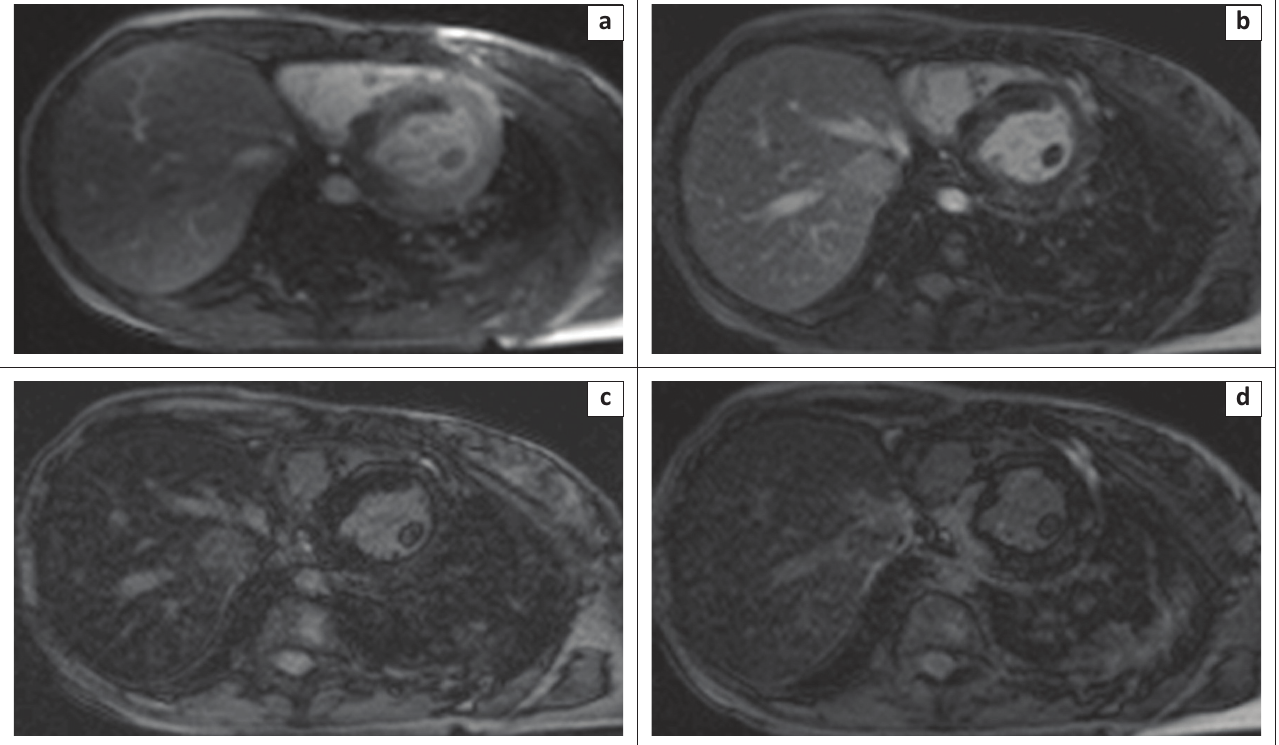
FIGURE 7: Axial post-contrast TRUFI MR images performed at time intervals after intravenous gadolinium injection: (a) Dynamic; (b) 2 minutes; (c) 5 minutes; (d) 12 minutes